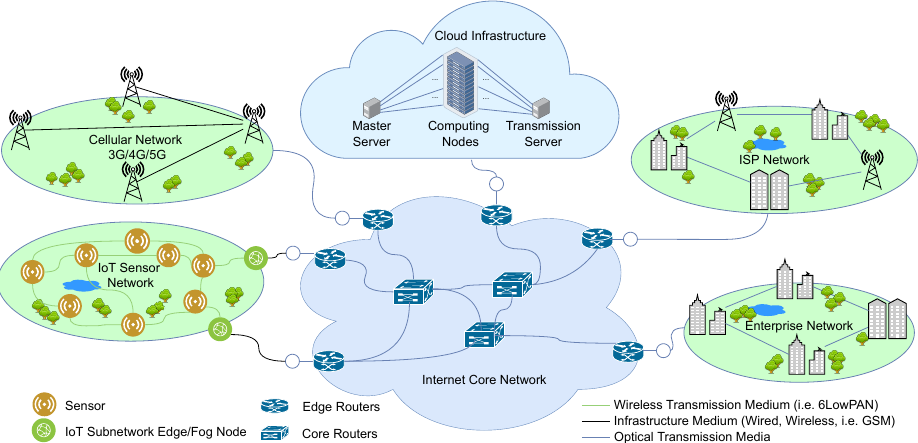
Figure 1. An architectural model consisting of access networks, Internet core networks and the cloud data